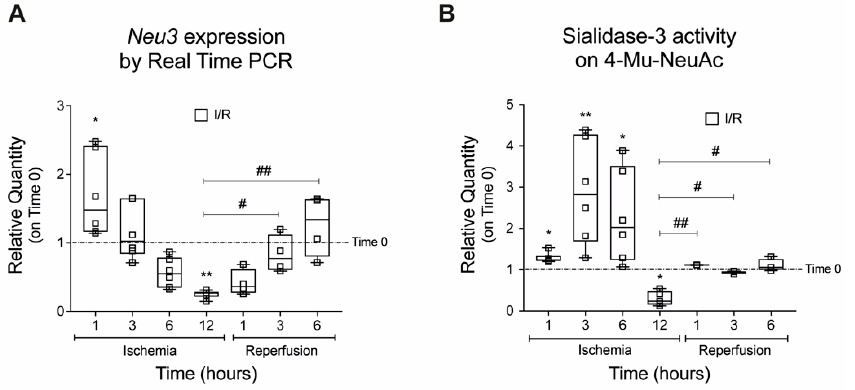
Figure 3. Effects of ischemia and reperfusion on Neu3 expression and Sialidase-3 activity . ( A ) Expression of sialidase Neu3 measured by real time PCR; ( B ) enzymatic activity of sialidase-3 measured on the synthetic substrate 4-Mu-NeuAc. Data are expressed as relative quantities compared with H9c2 not exposed to IRI and collected at the beginning of the experiments ( Time 0 dashed line ). Each square in the graphs represent an experimental replicate. Statistical significance was determined by the nonparametric Kruskal-Wallis test. * p < 0.05; ** p < 0.01. The # symbol indicates the statistical significance as compared to 30 ′ ischemia. # p < 0.05; ## p < 0.01.